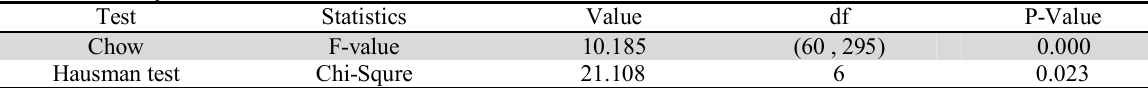
The summary of Hausman and Chow